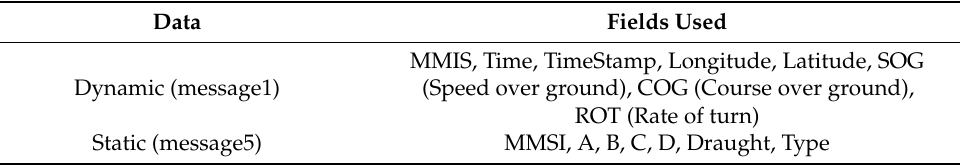
Table 1. Fields selected from dynamic and static